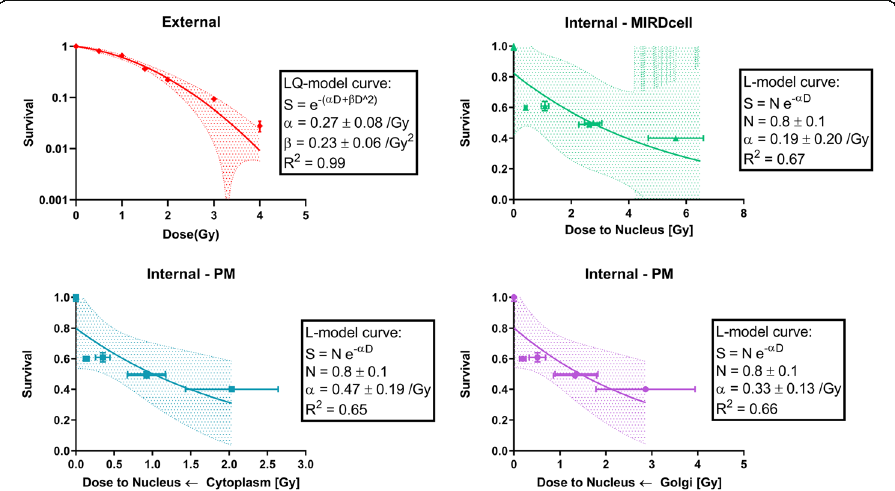
Fig. 9 Dose-response curves corresponding to x-ray irradiation (top left) and 177Lu-DOTATATE (top right: MIRDcell, bottom left: PM with internalized source in cytoplasm, bottom right: PM with internalized source in Golgi). Each data point is plotted as the mean